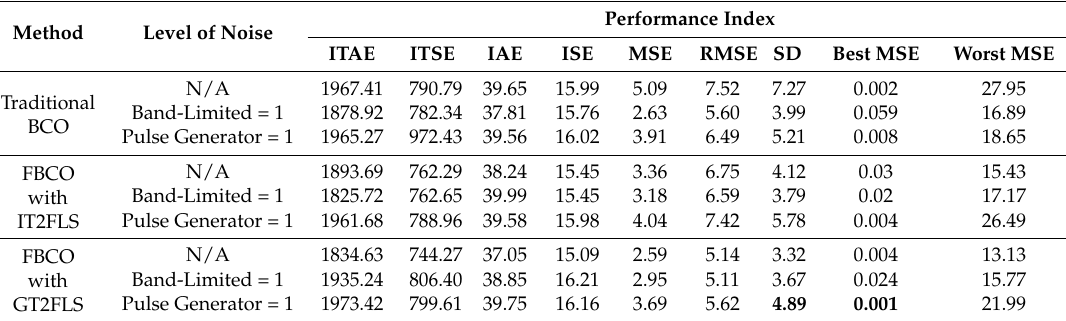
Table 8. Simulation results minimizing Footprint Uncertainty (FOU) and increasing volume.